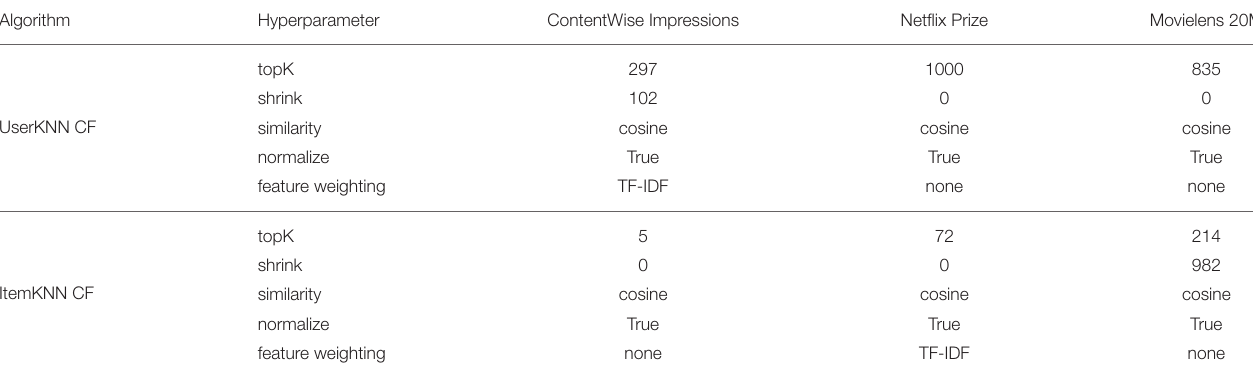
TABLE A1 | Hyperparameter values for collaborative KNN recommender algorithms on all datasets.